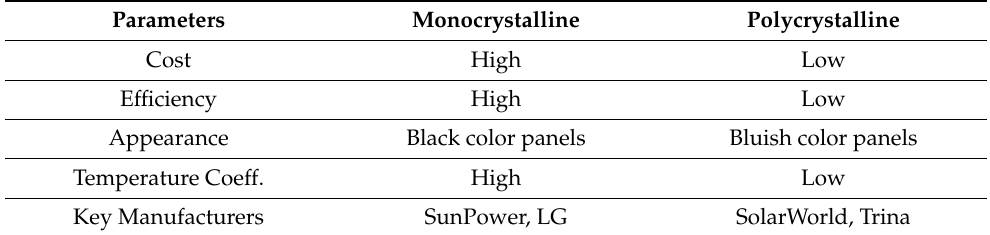
Table 1. Monocrystalline vs polycrystalline solar panels. Adapted from [19].